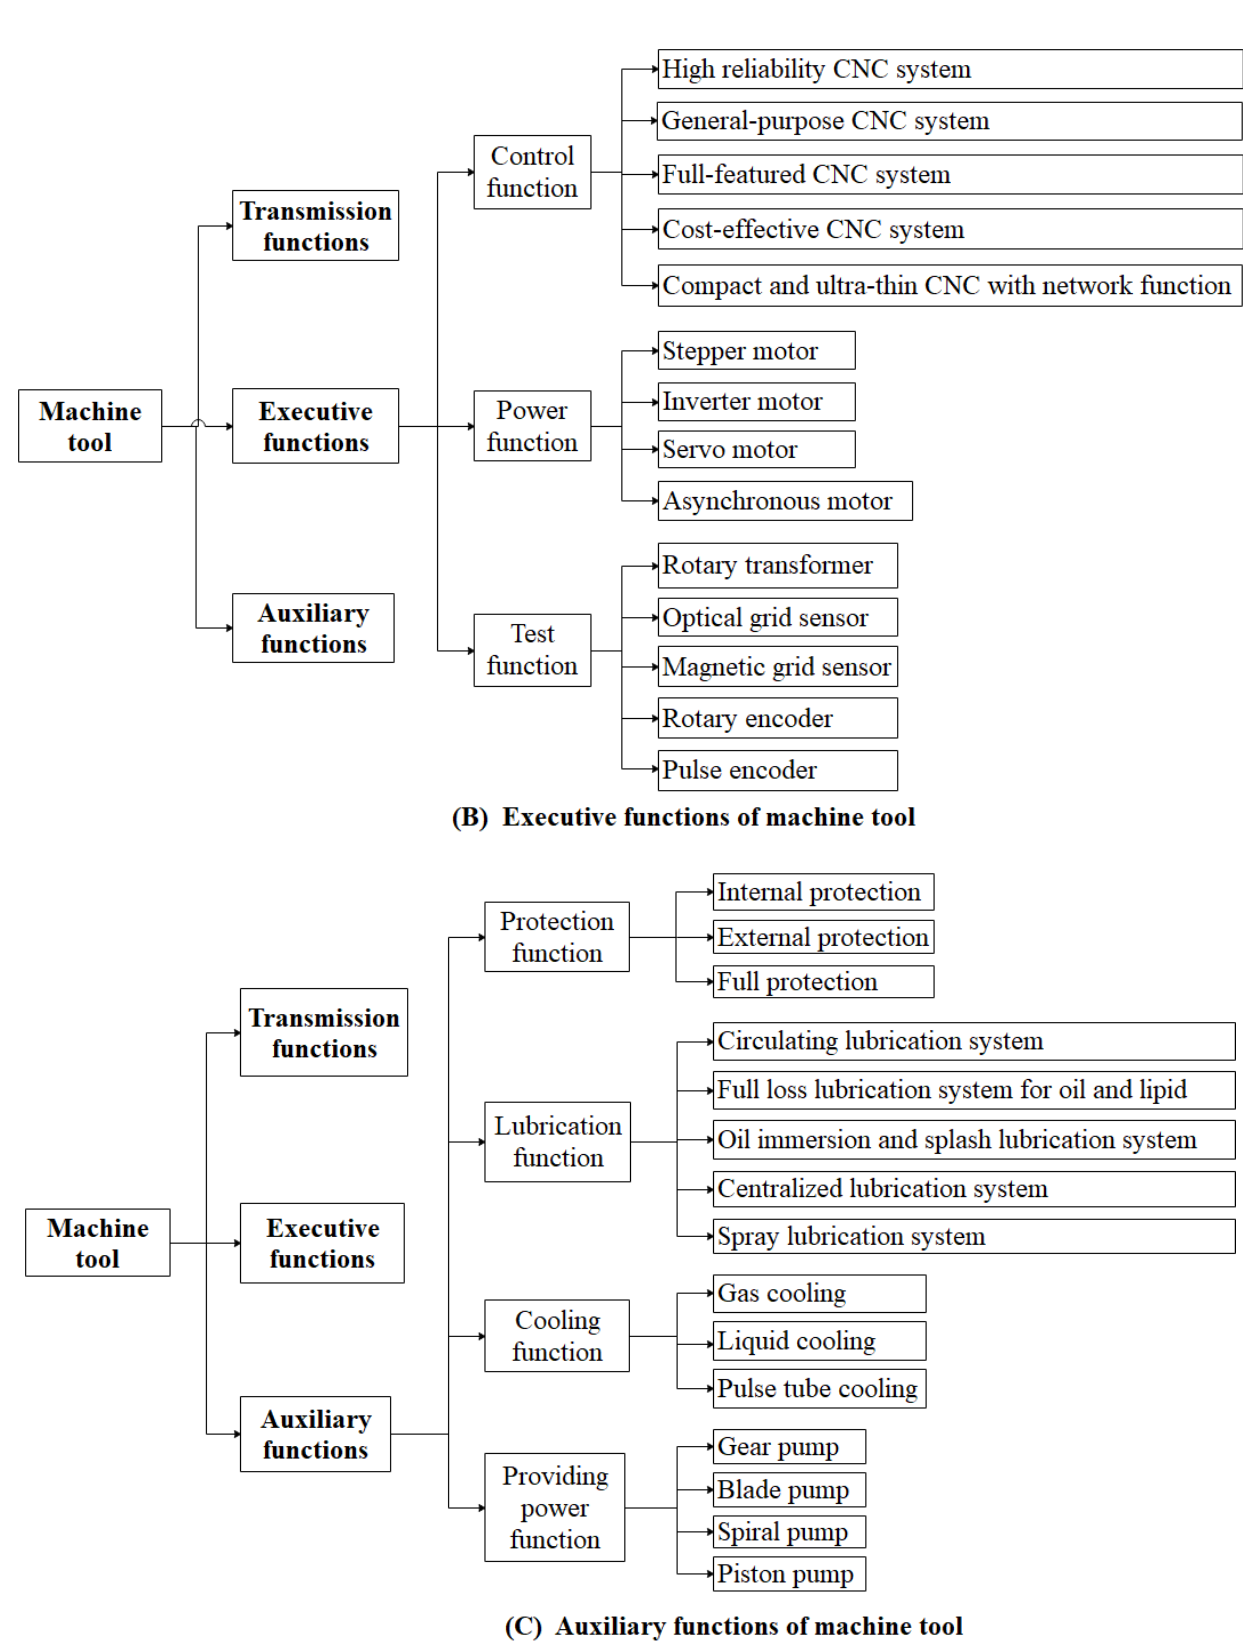
Figure 8. Lathe knowledge base.